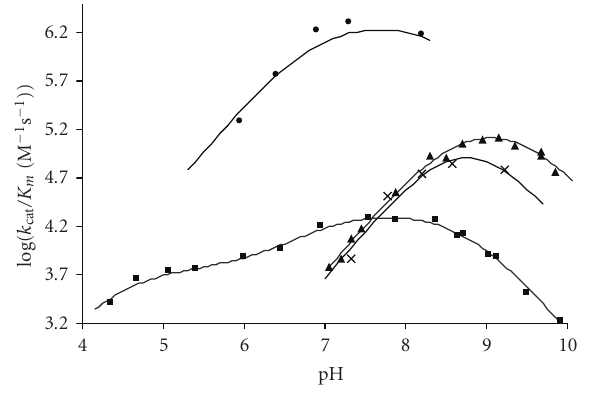
Figure 1: Plot of log k cat /K m for ( (cid:2) ) ZnBCII-, ( • ) CoBCII-, ( (cid:3) ) CdBCII-, and (x) MnBCII-catalysed hydrolysis of cephalexin.